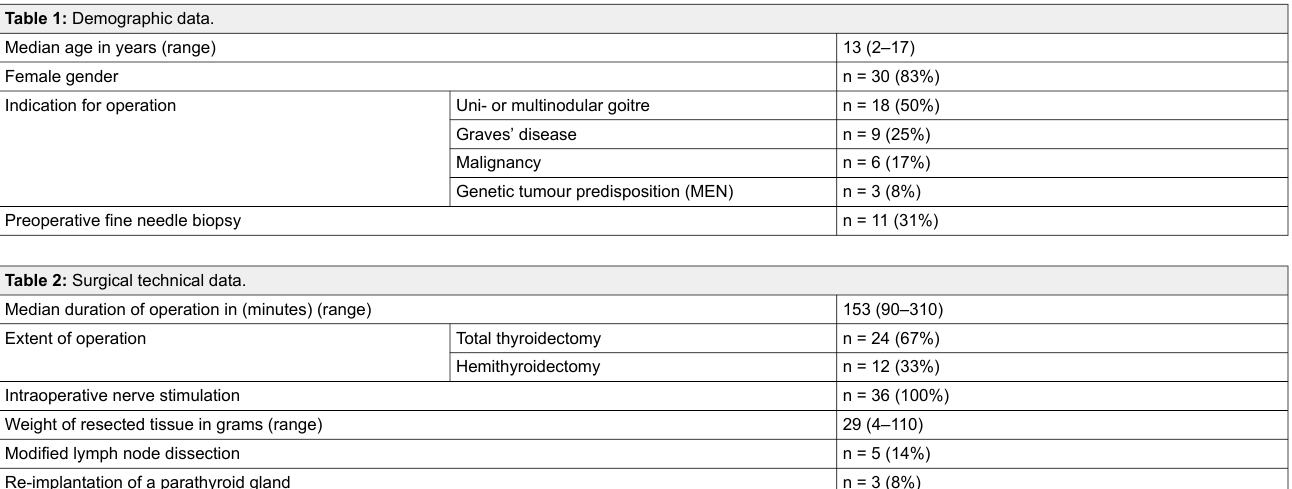
Table 2: Surgical technical data. Median duration of operation in (minutes)